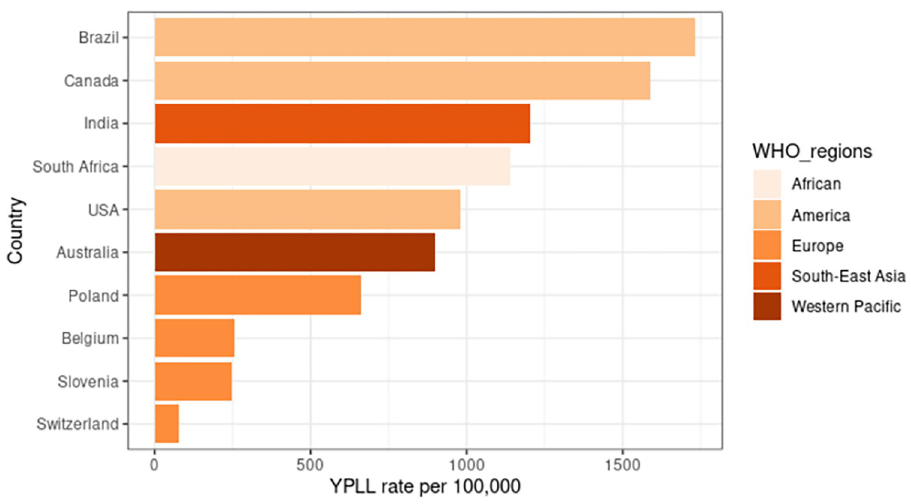
Fig 3. The YPLL rate of countries with available